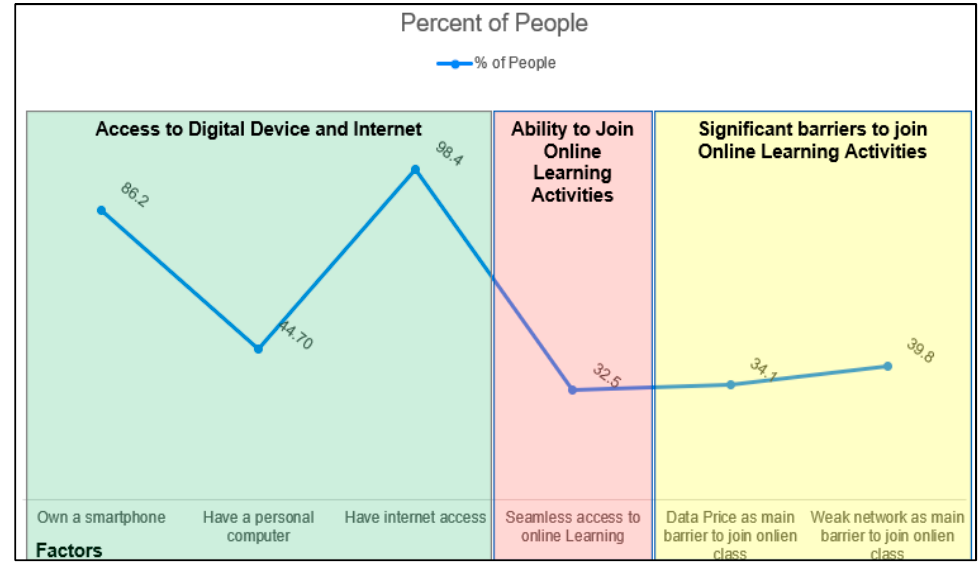
Figure 1. Internet subscribers in Bangladesh and access type.